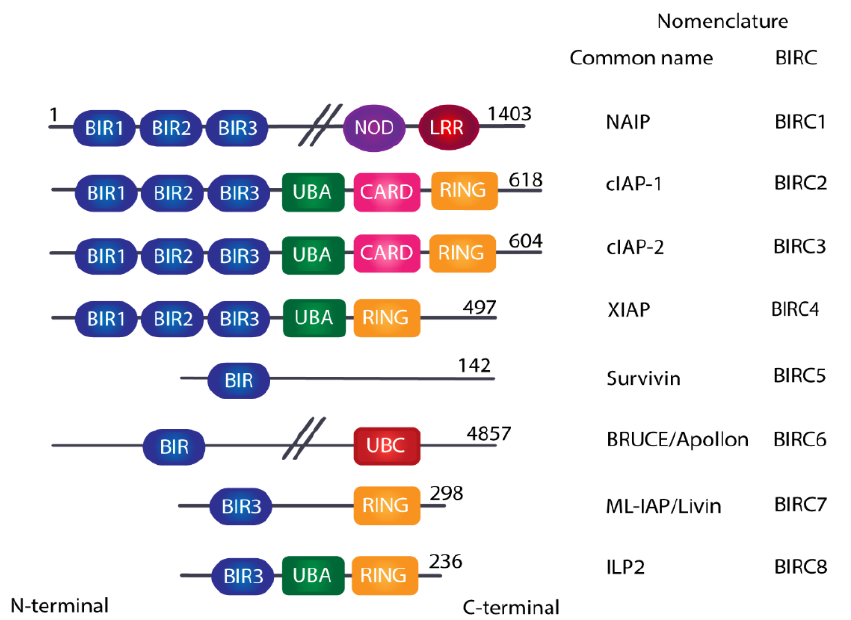
Figure 1. Schematic representation of the IAP family members’ structure. The nomenclature, length, and domains of the different proteins are shown. Abbreviations: BIR (Baculoviral IAP Repeat), NOD (Nucleotide-binding and Oligomerization Domain), LRR (Leucine Rich Repeat), UBA (Ubiquitin- Associated), CARD (Caspase-Associated Recruitment Domain), RING (Really Interesting New Gene), UBC (Ubiquitin-conjugating).